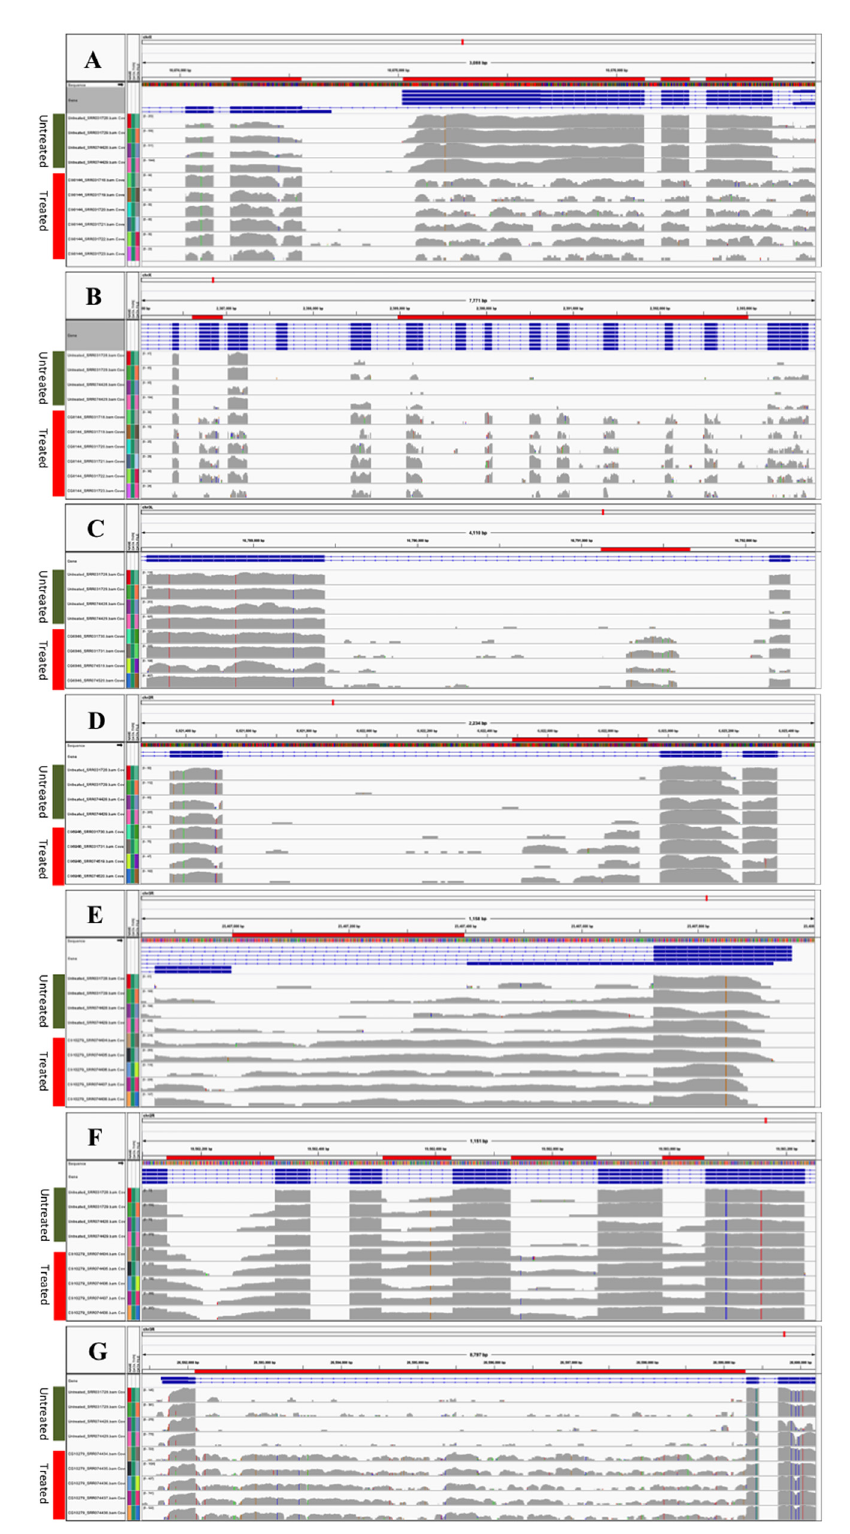
Fig 2. Visualization of splicing junctions and retained introns. In each panel, the first four lines denote samples from the untreated condition; the other lines denote samples from the RNAi-treated condition.